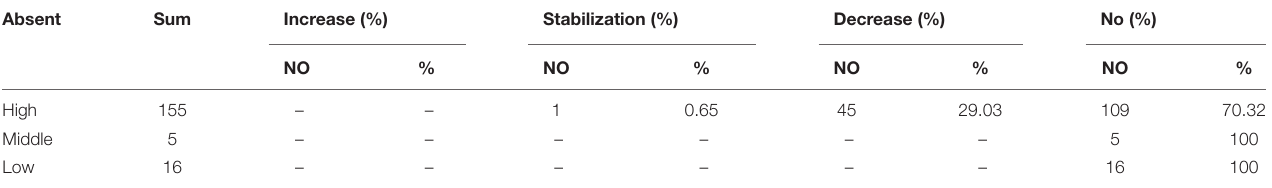
TABLE 4 | Results of reported trends of the Asiatic Black Bear population size in the past ten years’ questionnaires in “presence” grids. Present